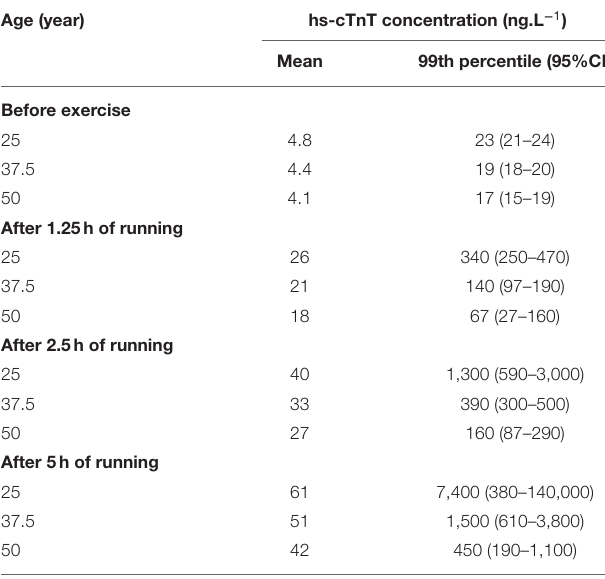
TABLE 3 | Meta-analyzed mean and upper reference limit (99th percentile) of serum concentration of high-sensitivity cardiac troponin T (hs-cTnT) in male athletes of three ages before and adjusted 2.5h after running a for three durations with a mean heart rate of 155 min − 1